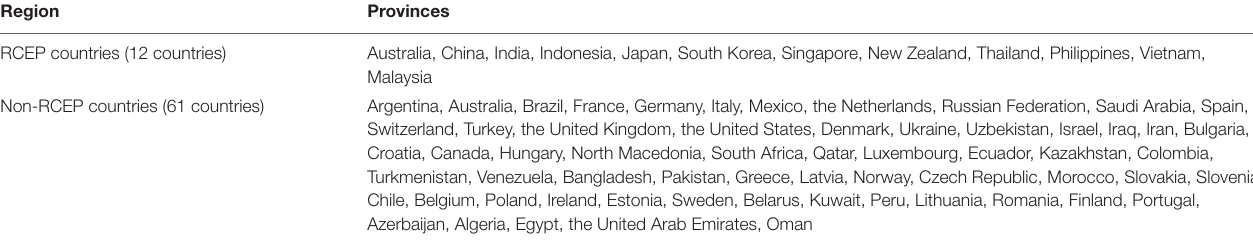
TABLE A1 The specific countries of RCEP and non-RCEP countries. Region Provinces RCEP countries (12 countries) Non-RCEP countries (61